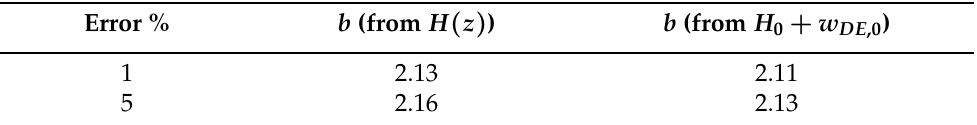
Table 2. The same as in Table 1 but with the galaxy-based Swiss-cheese